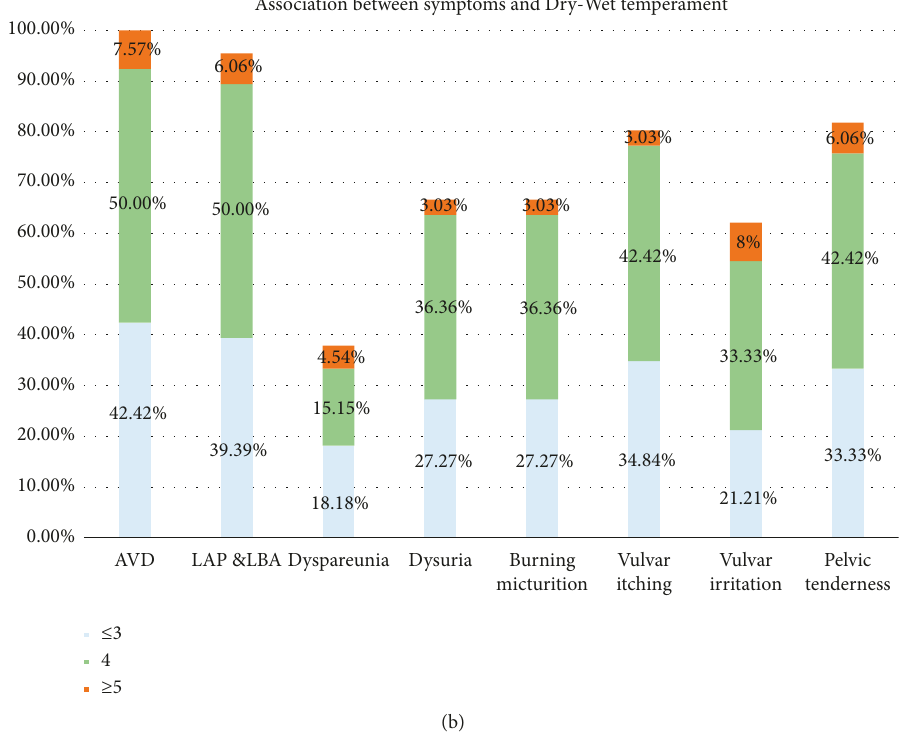
Figure 8: Association between symptoms with temperament. (a) Warm-cold and (b) dry-wet